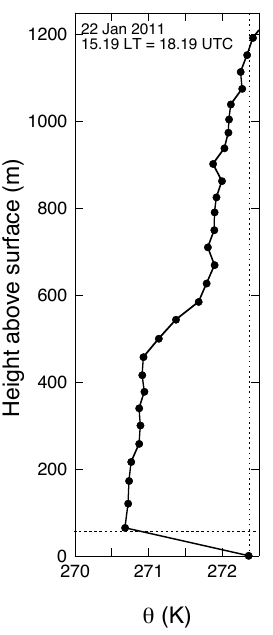
Fig. 11. Vertical profile of potential temperature (in K) from a ra- diosonde launched on 22 January 2011 at 15:19LT ( = 18:19UTC). The horizontal dashed line indicates the height at which d θ/ d z changes sign, while the vertical dashed line illustrates that possi- ble convection extends up to 1150m, the height at which potential temperature equals surface potential temperature.